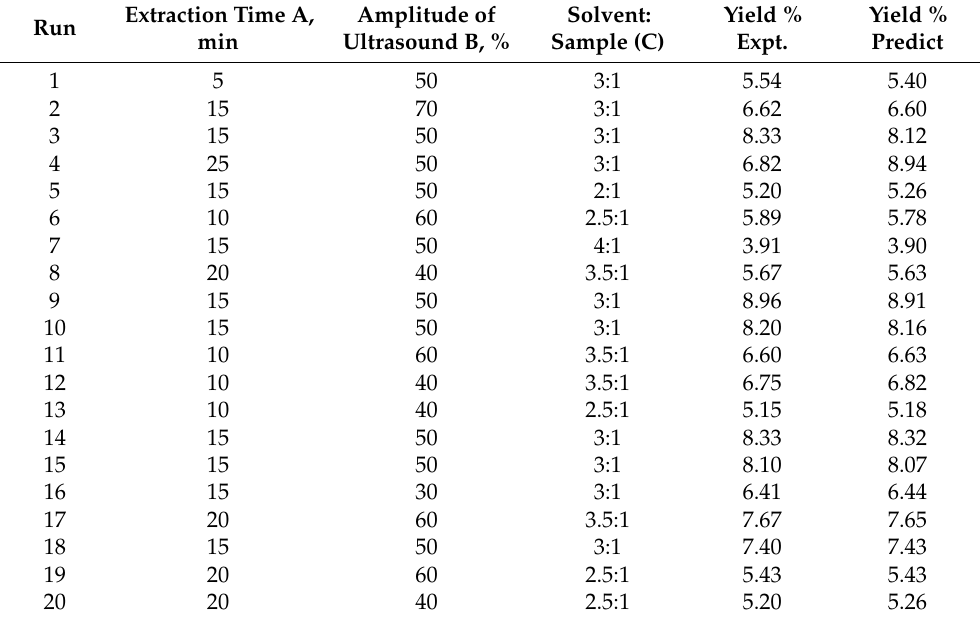
Table 2. Experimental designs of the three levels and their experimental results and predictive